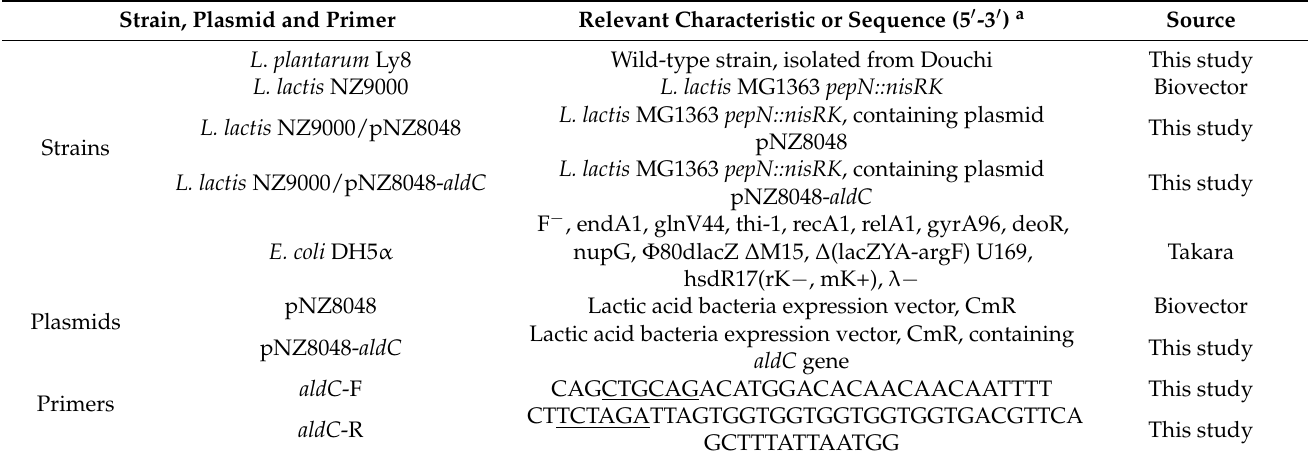
Table 1. Bacterial strains, plasmids and primers used in this